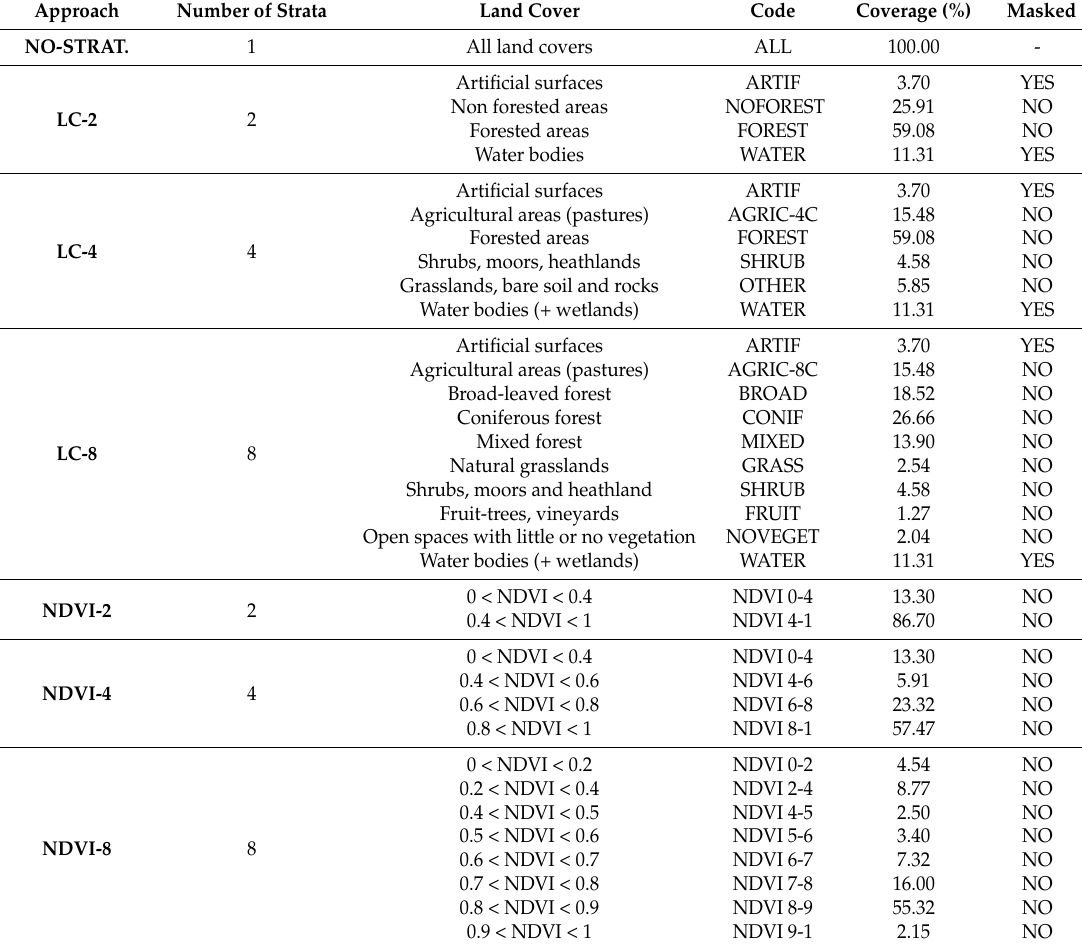
Table 3. Stratification